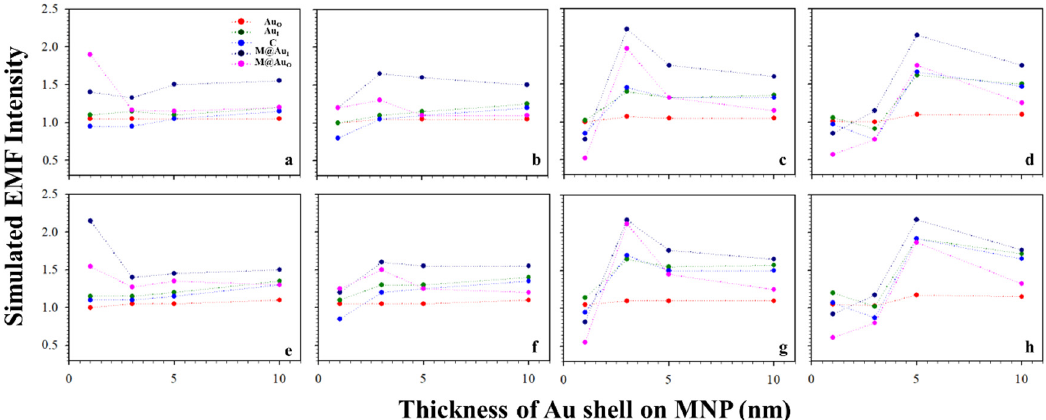
Figure 6. EMFs vs. Au shell thickness on MNP with the interparticle distances defined by Ab1–antigen–Ab2 binding. Plot of the simulated EMF intensity for the dimer of “Ab1/Au 60 nm –CEA ( a – d ) or NSE ( e – h )–Ab2/M@Au” vs. different thicknesses of Au shells on MNPs at different locations of Au O , Au I , C, M@Au I , and M@Au O . Different sizes of Fe 3 O 4 cores of 6 ( a , e ), 10 ( b , f ), 20 ( c , g ), and 30 nm ( d , h ).